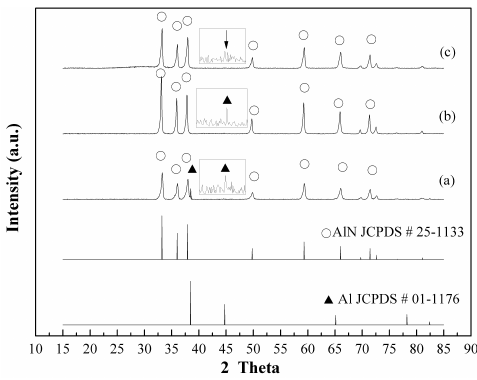
Figure 4. XRD patterns of AlN/Al powders prepared by thermal nitridation at ( a ) 850 °C ( b ) 950 °C ( c ) 1050 °C (heating rate: 15 °C/min, held for 1 h, Al/NH 4 Cl = 1/1).